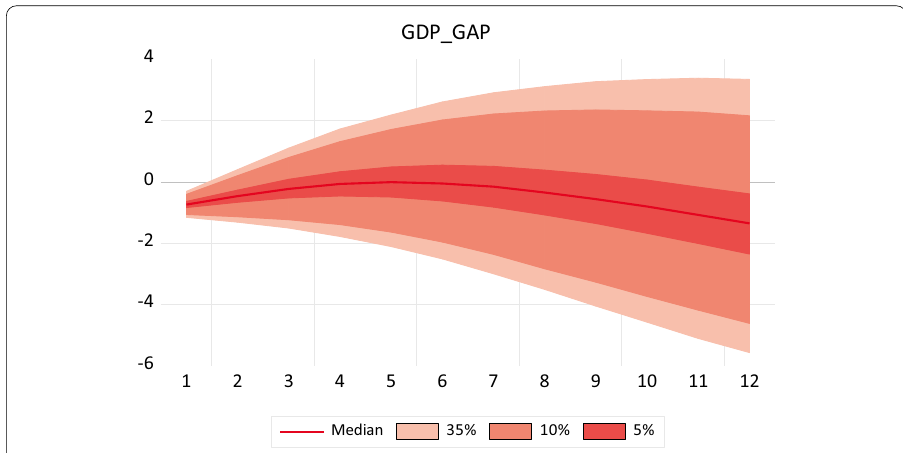
Fig. 2 Forecasting performance of GDP_GAP using Bayesian VARX, Litterman/Minnesota prior type, 2020:1 2020:12. Source : Authors’ calculations